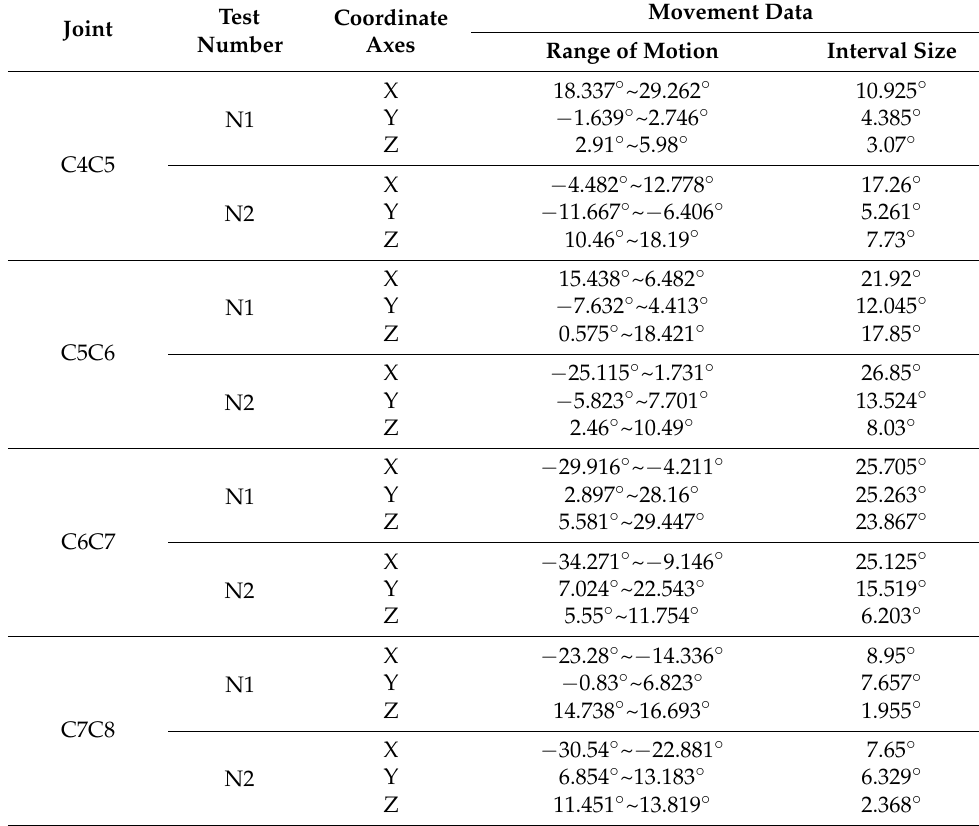
Table 1. Data of each joint movement when moving the body in Y-direction. Joint